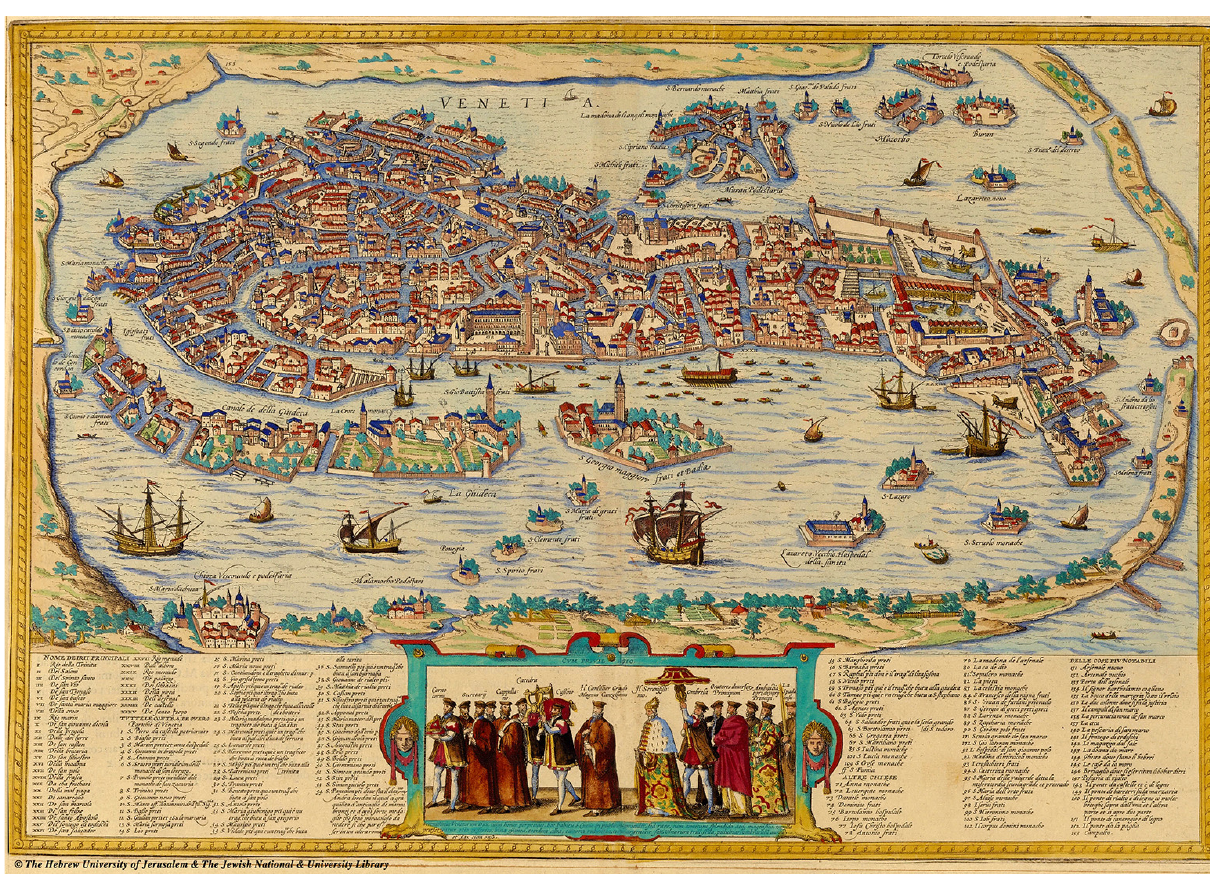
Figure 3. Map of Venice, 1572, by Georg Braun and Frans Hogenberg. Source: Hogenberg